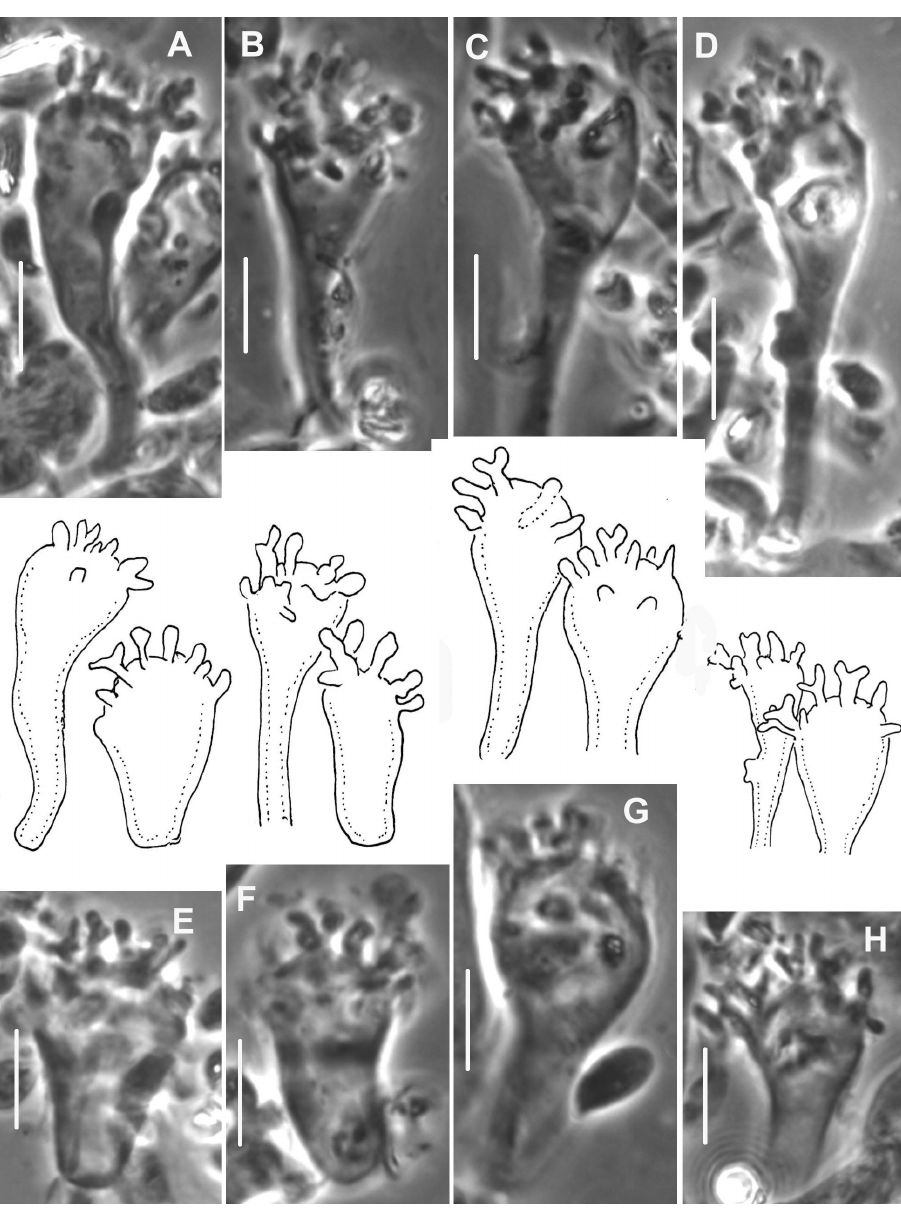
Figure 32. Mycetinis curraniae. Cheilocystidia. Line drawings represent photographs, not to scale. Standard bars = 10 µm. ZT 949